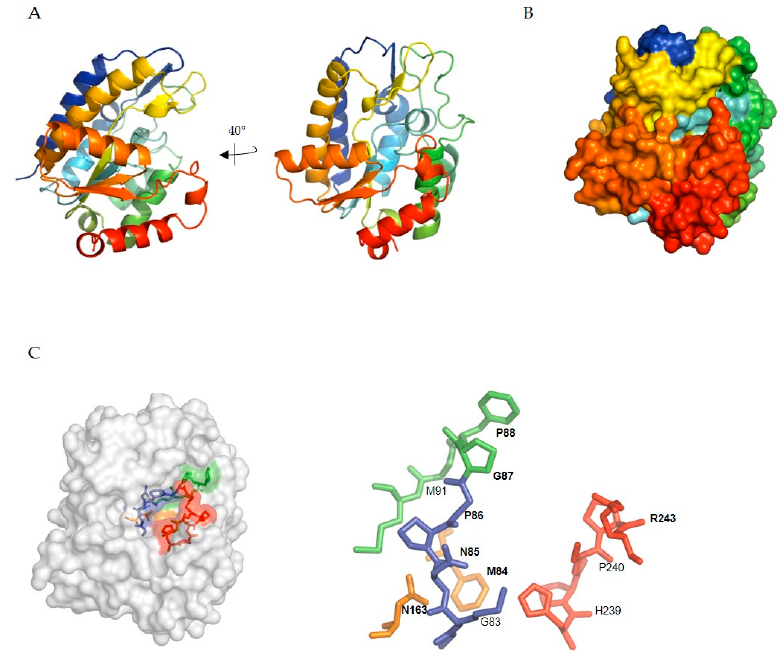
Figure 5. In silico modeling of human single-strand-selective monofunctional uracil-DNA glycosylase 1 (SMUG1) ∆ 25- 270. ( A ) Secondary structure cartoon of hSMUG1 ∆ 25-270, rainbow colored blue → red from N- to C terminus. ( B ) Over- view of active sites pocket and cleft shown as surface; rainbow colored blue → red from N- to C terminus. ( C ) Active site residues of hSMUG1 (left: overview; right: detail); G83-G87 (blue); P89-M91 (green); F98 and N163 (orange); H239-R243 (red). A homology model for hSMUG1 was built based on Xenopus laevis SMUG1 (PDB ID: 1OE4). hTERC is one of the main components of the telomerase holoenzyme, together with the telomerase reverse transcriptase (hTERT) and the dyskerin complex (DKC1, NHP2, NOP1, and GAR1) [174,175]. Experimental data indicated that SMUG1 was required for the productive binding of DKC1 to hTERC. As the interaction between hSMUG1 and hTERC might differ when hTERC is present in the telomerase holoenzyme and when hSMUG1 interacts with DKC1, we decided to superimpose the SMUG1–DKC1 complex, previously characterized in [88], on the cryo-EM structure of the human telomerase com- plex [176]. Our SMUG1–DKC1 structure was superimposed onto each of the two DKC1 molecules present in the human telomerase (Figure 6C,D). In both the configurations, our modeling predicts a significant steric clash of hSMUG1 with the other components of the human telomerase, suggesting that SMUG1 most likely is not a constitutive component of the complex but dynamically interacts with the enzyme upon recognition of modified ba- ses of hTERC (Figure 6C,D).